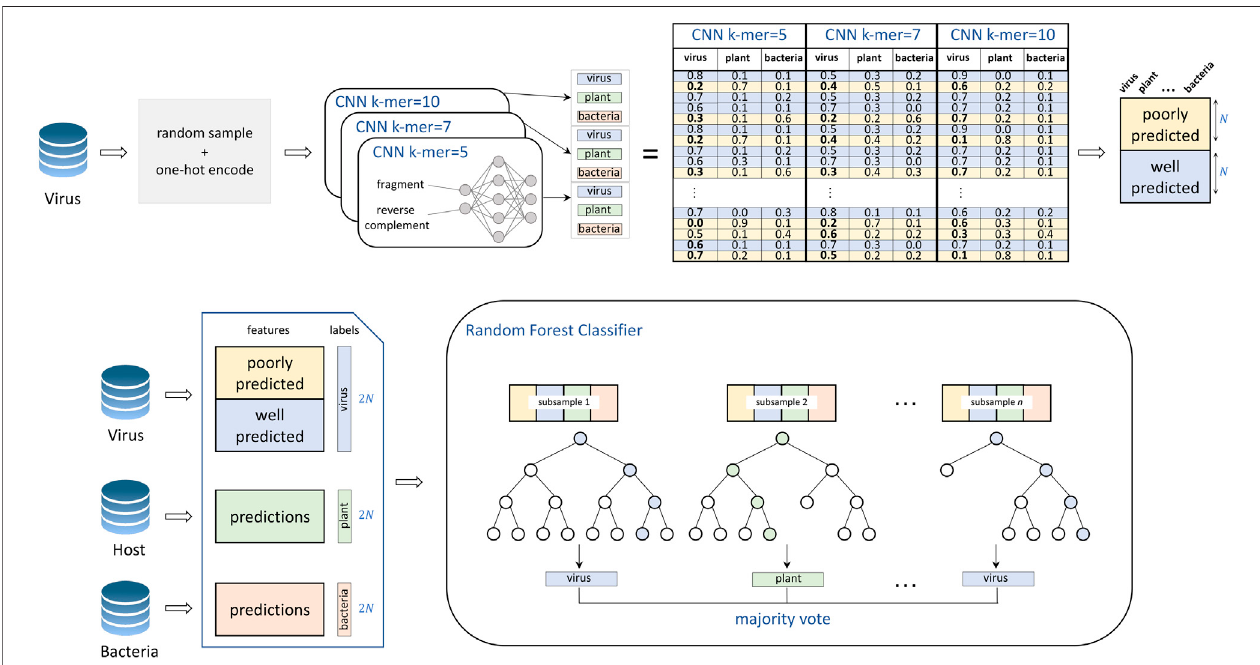
FIGURE 2 | Training of the VirHunter ’ s machine learning module. The individual network predictions are subsetted to contain an equal number of both poorly predicted (prediction value for viral class < 0 . 8) and well-predicted (prediction value ≥ 0 . 8) viral fragments (with the goal to overselect poor predictions relative to their overall frequency in order to drive the model to recognize even completely novel viruses). The random forest classi fi er uses these subsetted predictions for its